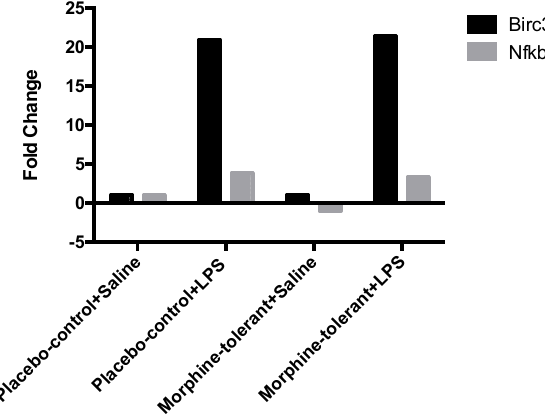
Figure 2. Inflammasome-related downstream gene expression in the rat brain in response to Lipopolysaccharides (LPS), with and without morphine tolerance. The expression of the inflammasome-related downstream signaling genes Baculoviral IAP Repeat-Containing 3 (Birc3) and NF-Kappa-B Inhibitor Alpha (Nfkbia) in the brains of rats given an i.p. injection of either 250 µg/kg LPS or saline, with and without morphine tolerance ( n = 3–5 rats per group), was determined using a Polymerase Chain Reaction (PCR) array. The data were calculated using the ΔΔ C T method relative to the control group (placebo-control + saline) and are represented as fold change.